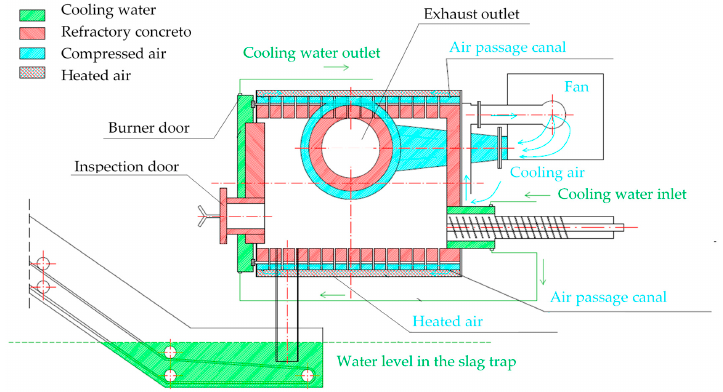
Figure 1. Burner used in the heating system.